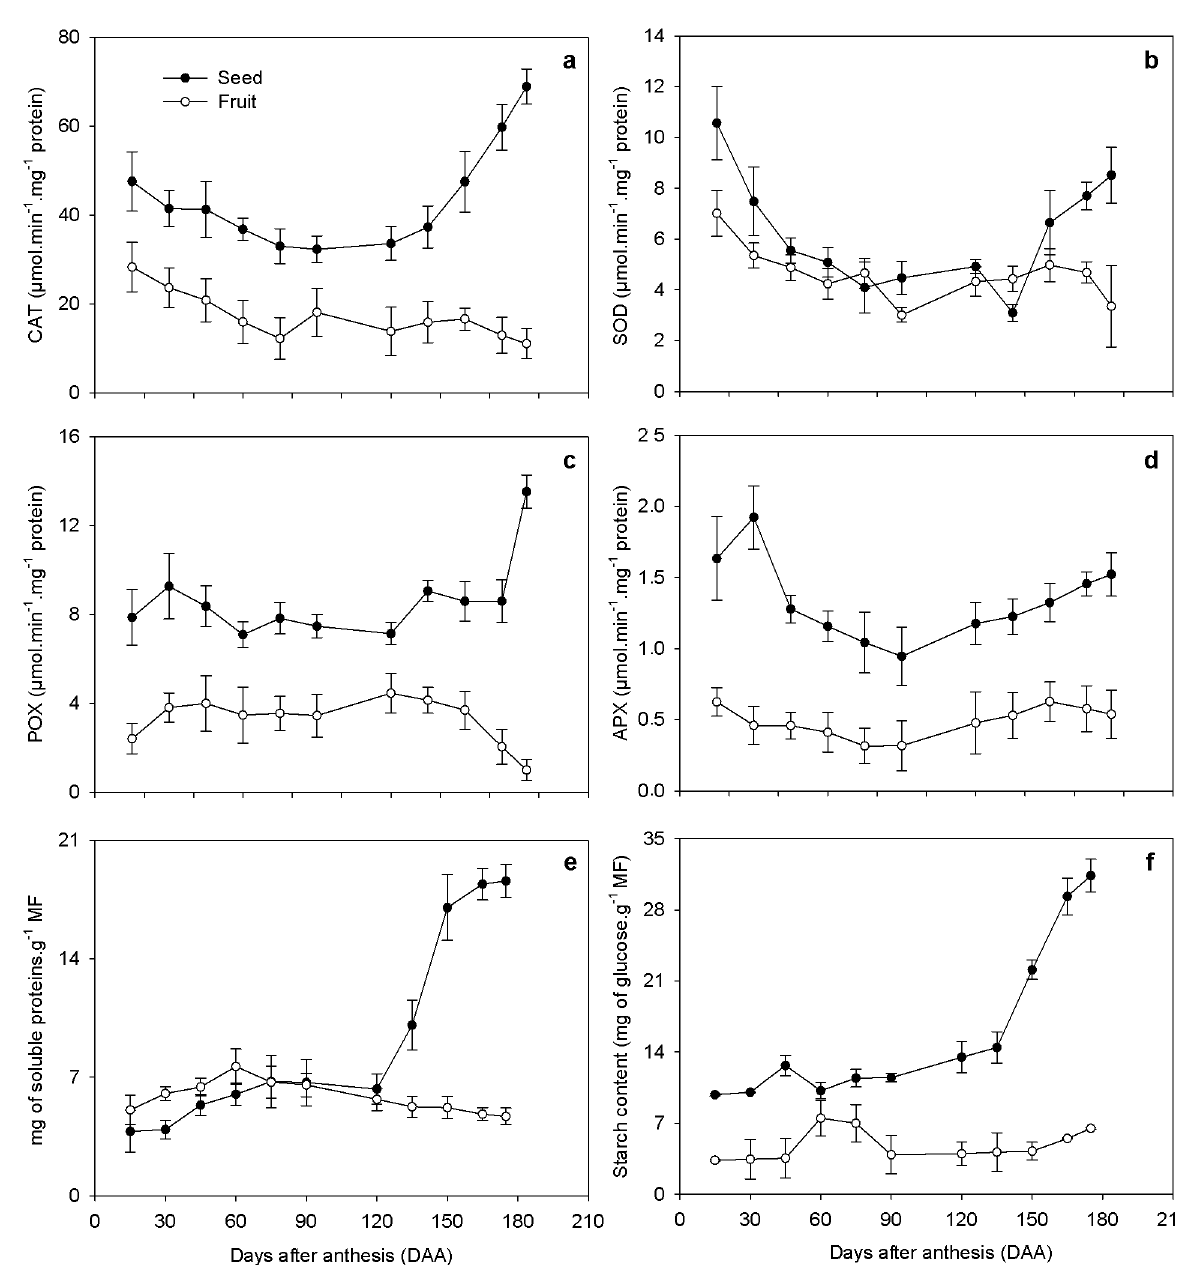
Figure 4 - Oxidative stress enzyme activity of Hevea brasiliensis L., seed, CAT ( a ), SOD ( b ), POX ( c ) and APX ( d ) in seeds and rubber tree fruit during development, n = 5 ± standard error and Protein ( e ), starch content ( f ), n = 5 ± standard